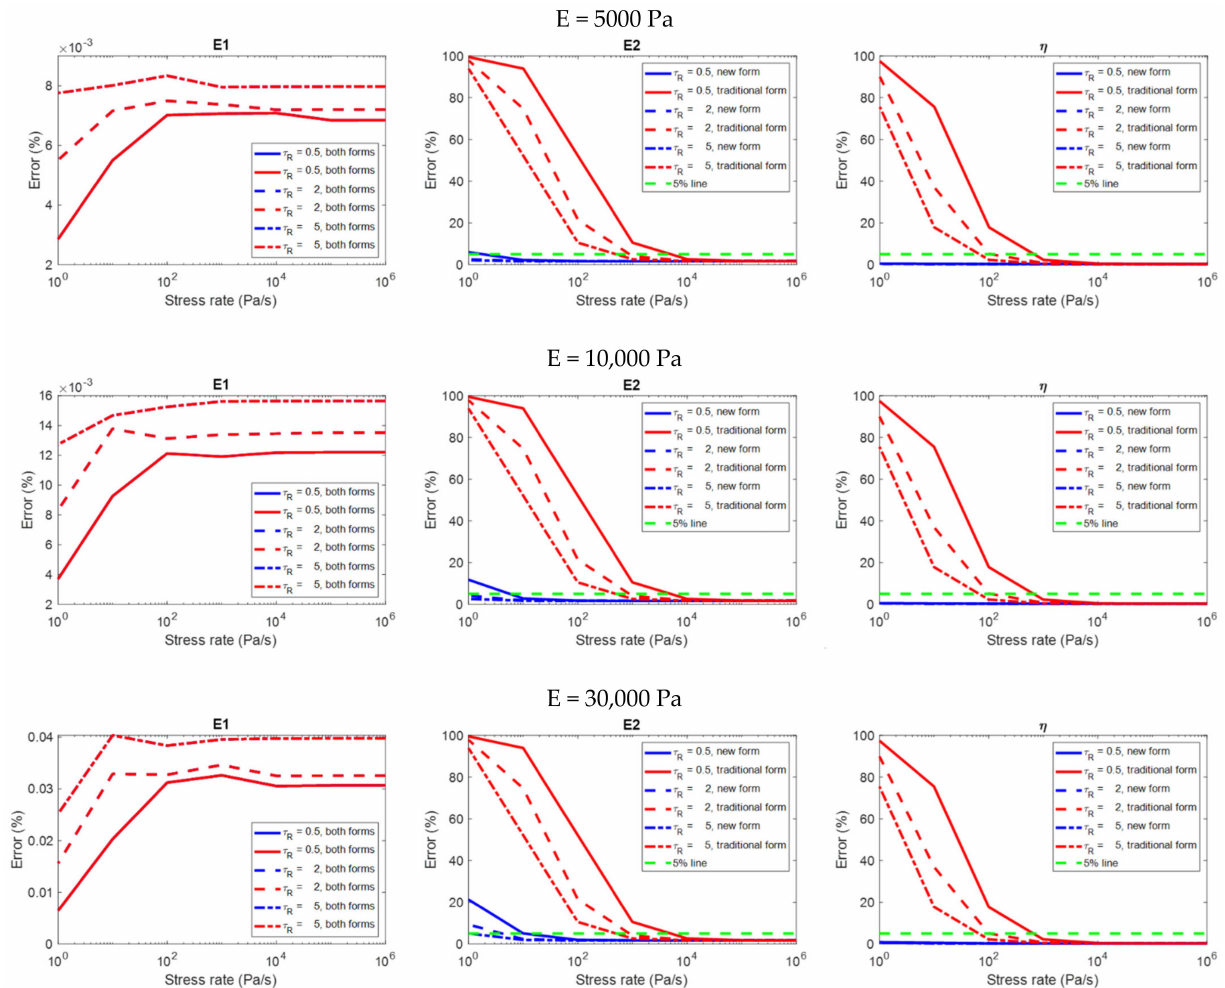
Figure 8. The relationship between the stress rate and the error in the evaluation of the viscoelastic properties on different material models in the creep simulation, analyzed using the two constitutive equation forms (i.e., the newly − introduced form derived with finite loading rate, and the traditional form derived with infinite loading